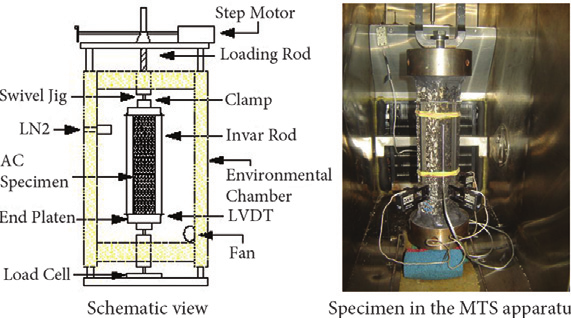
Fig. 1. Thermal Stress Restrained Specimen Test (TSRST) setup